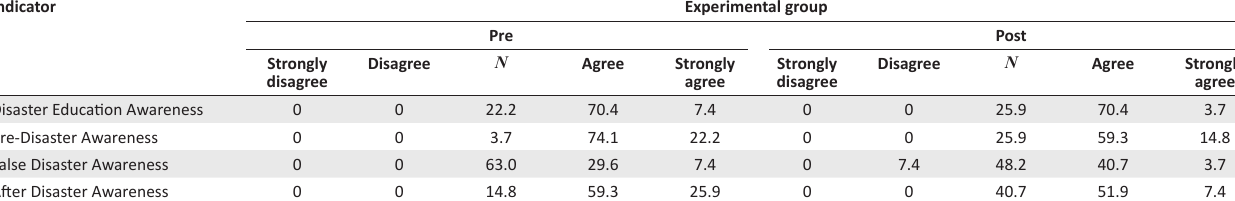
Maximum ideal score = 180. TABLE 3: N-gain score data on student disaster awareness. Schools